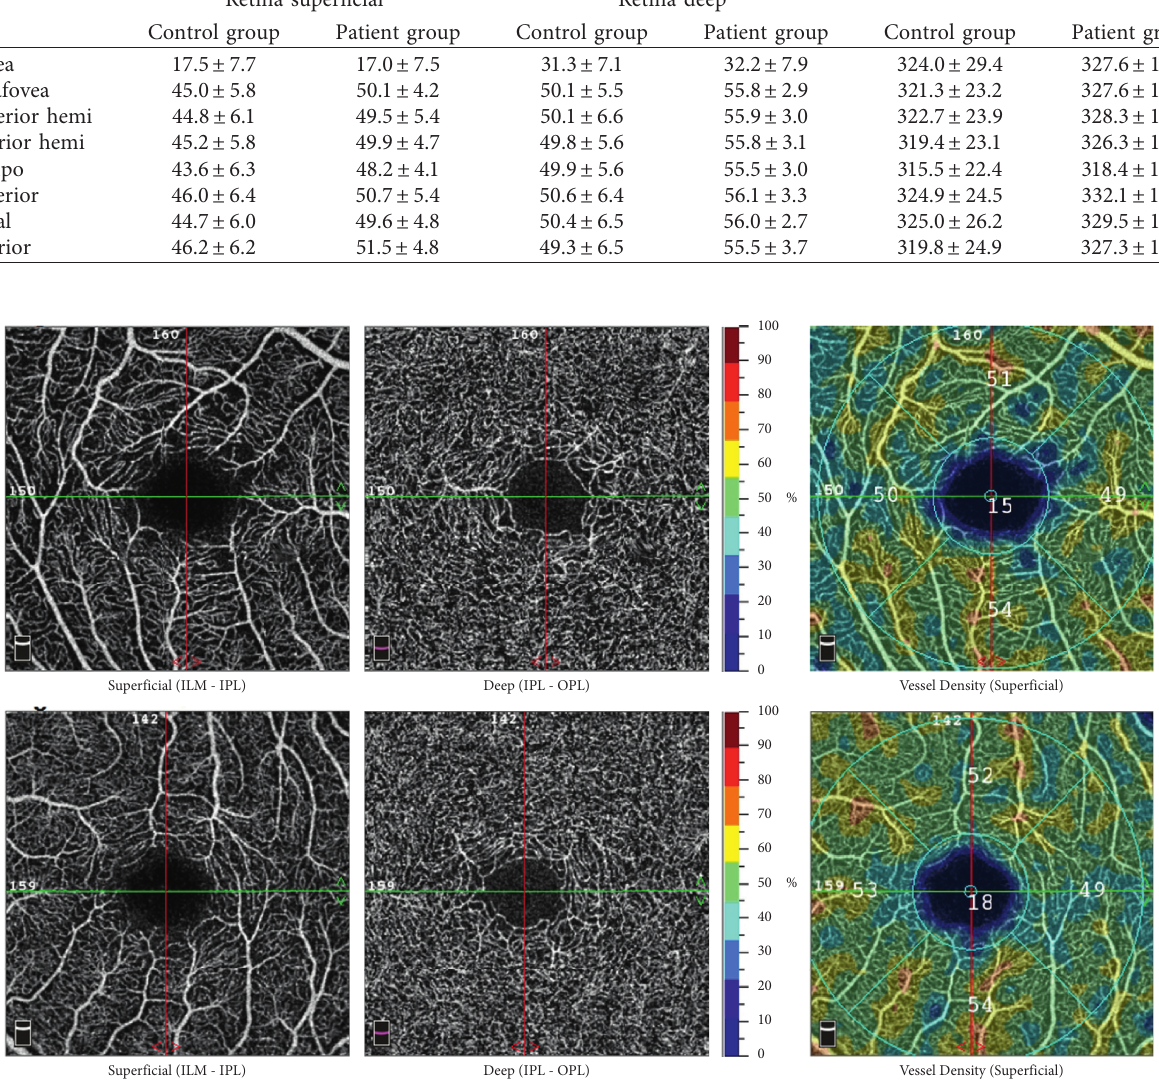
Figure 1: Optical coherence tomography angiography (OCTA) of the retina from a patient suffering from type 2 diabetes (a) and a subject who is healthy